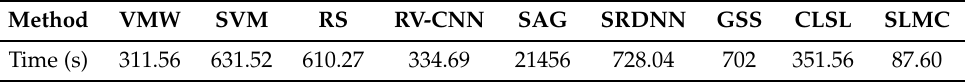
Table 4. Total times for different methods on dataset